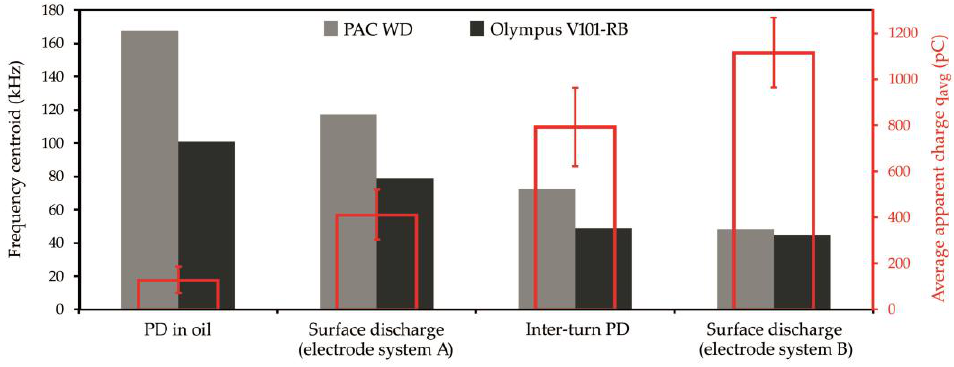
Figure 15. Influence of type and energy (value of apparent charge) of partial discharge on the centroid frequency of registered AE signal.